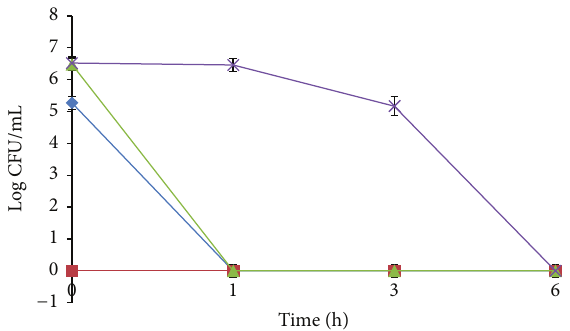
Figure 2: Survival of V. cholerae in sterile distilled water as control ( Q ), plain coffee ( ◼ ), coffee with sugar ( 󳵳 ), and coffee with condensed milk ( × ). Each point is the mean of four replicate